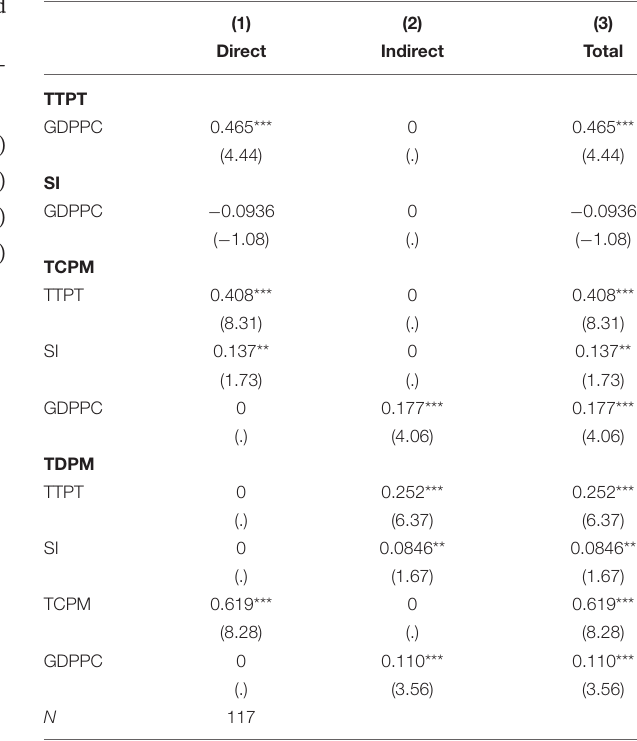
TABLE 5 | Direct, indirect, and total effects in the base model without